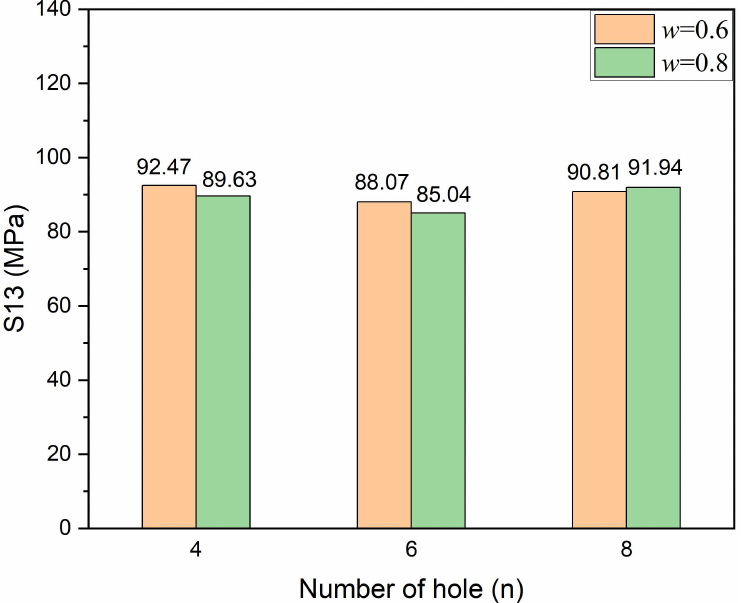
Figure 8. Maximum interlaminar shear stress (S 13 ) in Case.0.6/ n /2.5 and Case.0.8/ n /2.5.